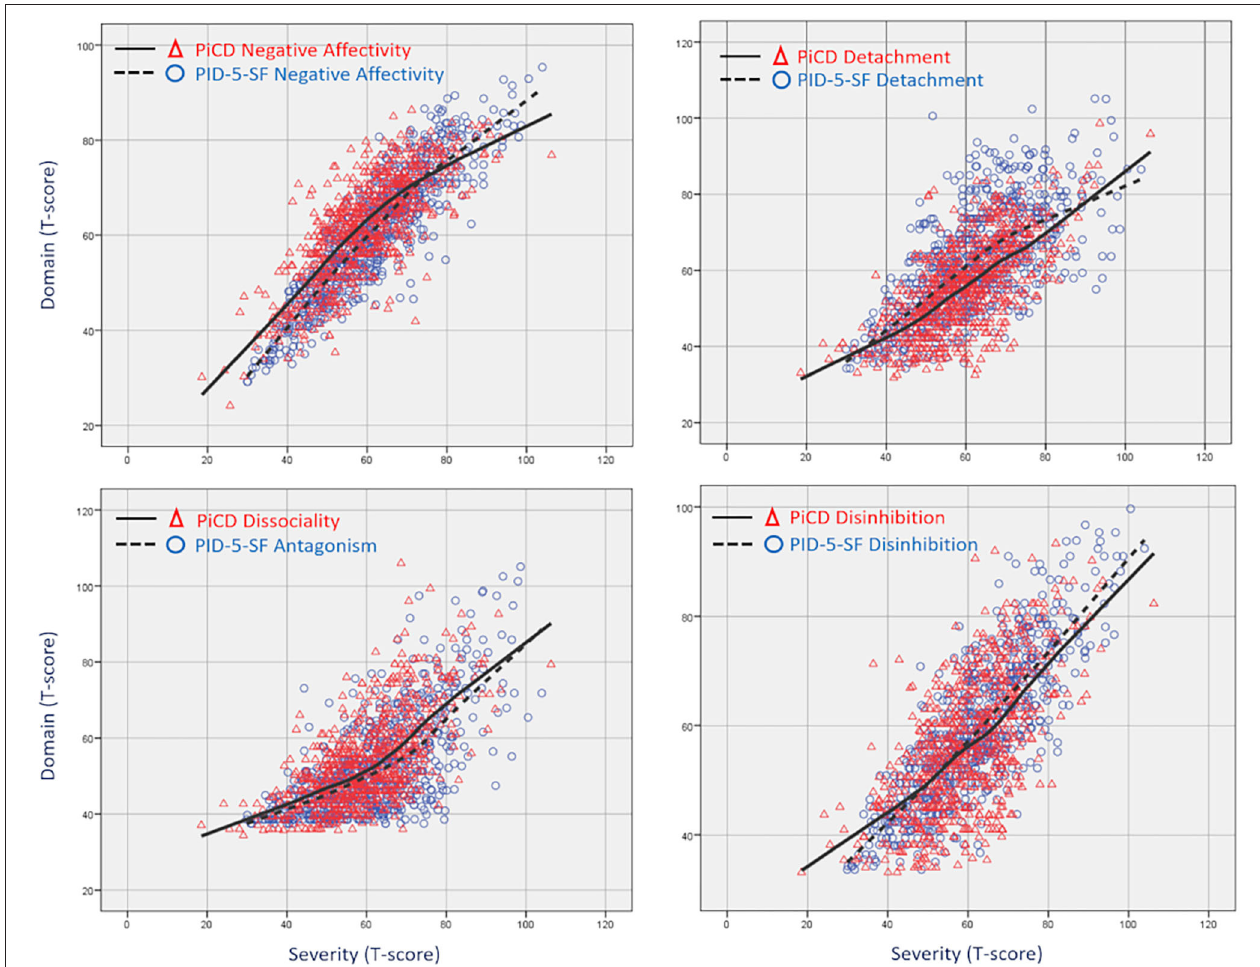
FIGURE 1 | Loess curves showing similar scores for the PiCD and the PID-5 domains as severity increases ( n its corresponding questionnaire: PiCD or